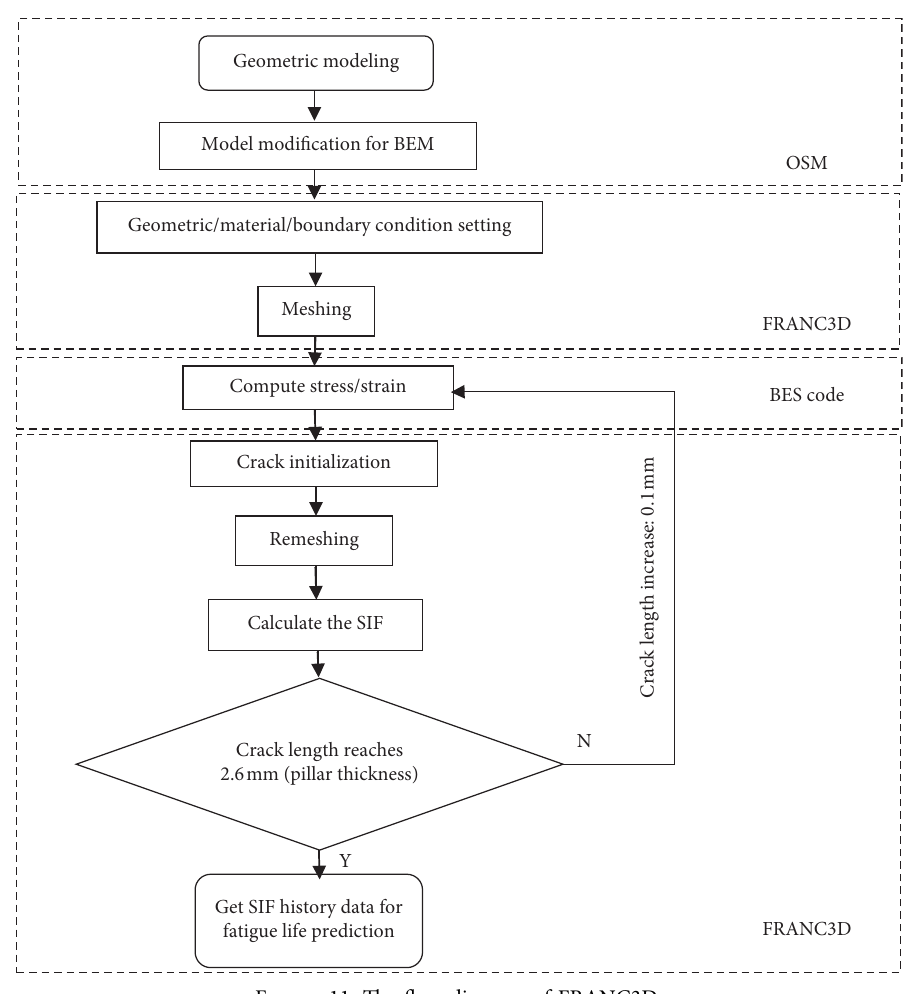
Figure 11: The flow diagram of